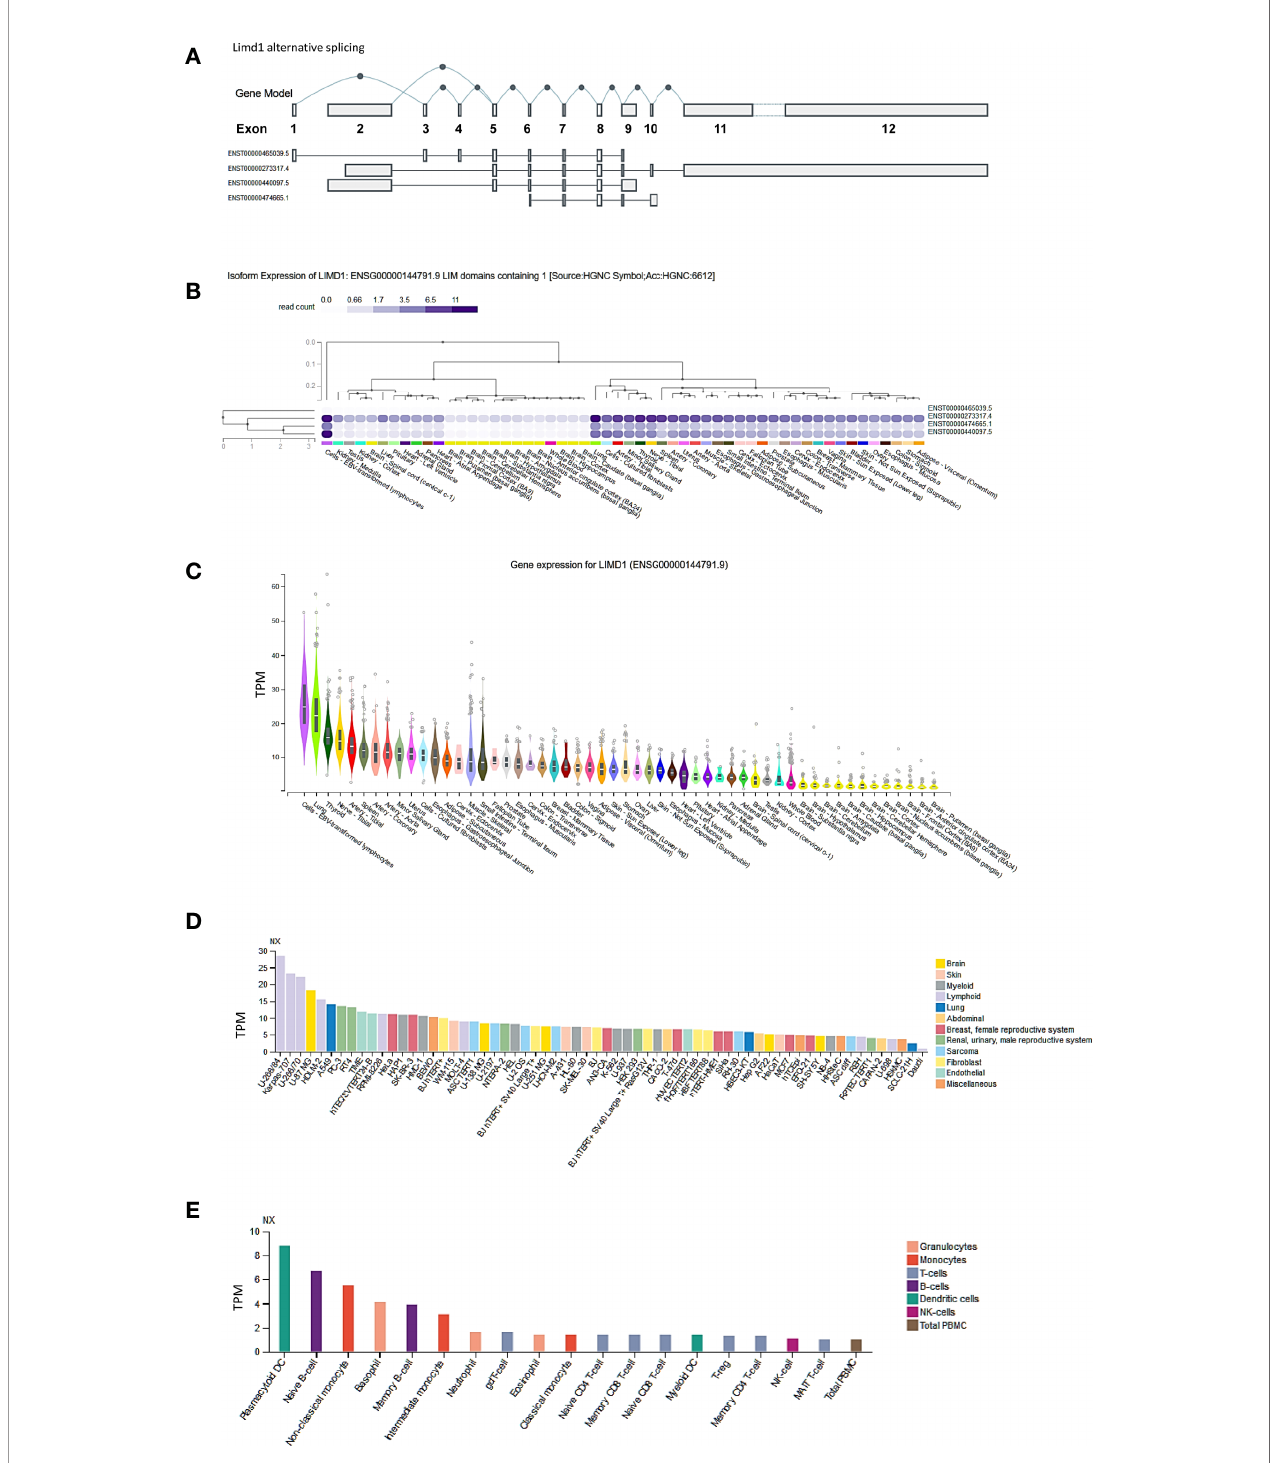
FIGURE 1 | Tissue- and cell-speci fi c expression of LIMD1. (A) Four splicing variants of Limd1 primary transcript, two of which encode proteins (676 aa for the dominant transcript ENST00000273317.4 and 620 aa for ENST00000440097.5). (B, C) Tissue-speci fi c expression of Limd1 splicing variants and gene. (D) Cell- speci fi c expression of Limd1 transcript. (E) Cell-speci fi c expression of Limd1 transcript in the blood. (A – C) are the results from the GTEx portal, and (D, E) from the ProteinAtlas portal. TPM, transcripts per million; NX, denoted normalized